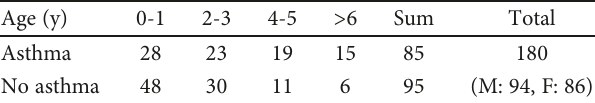
Table 1: The number of patients in each age